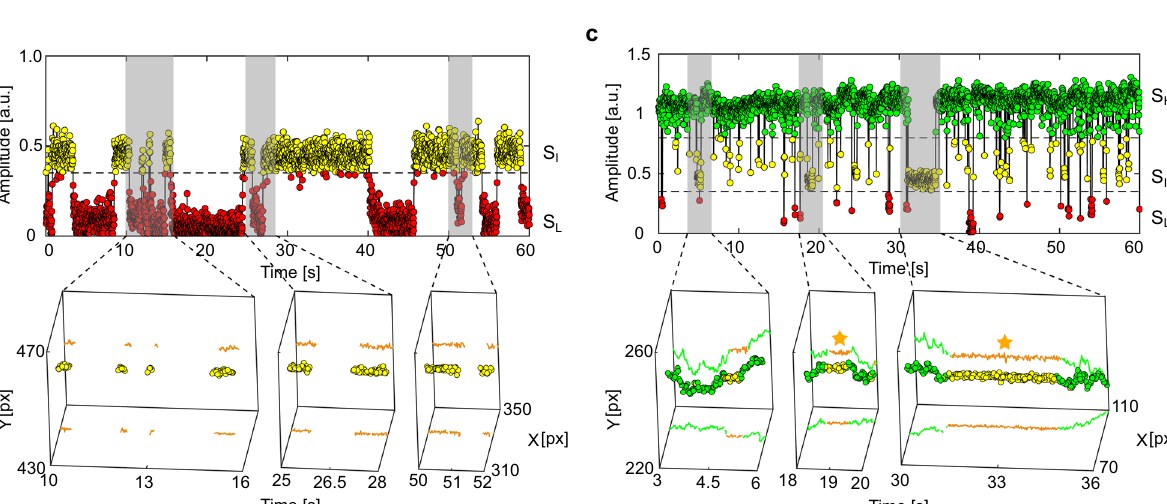
Correlation between lateral motion and TOM-CC channel